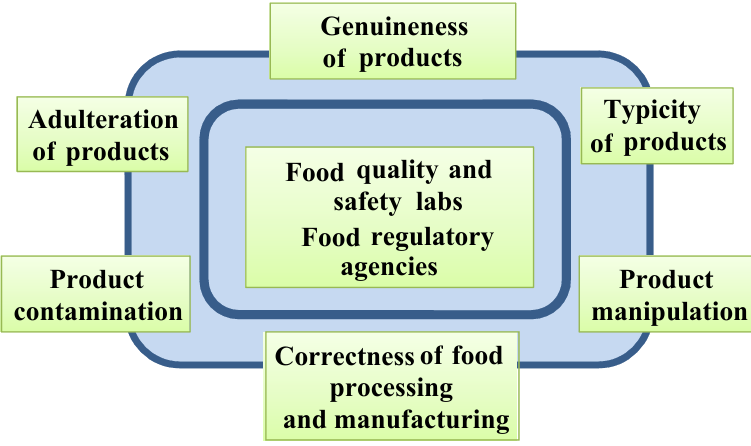
Figure 3. Scheme of the most important interactions of laboratories and regulatory agencies in food